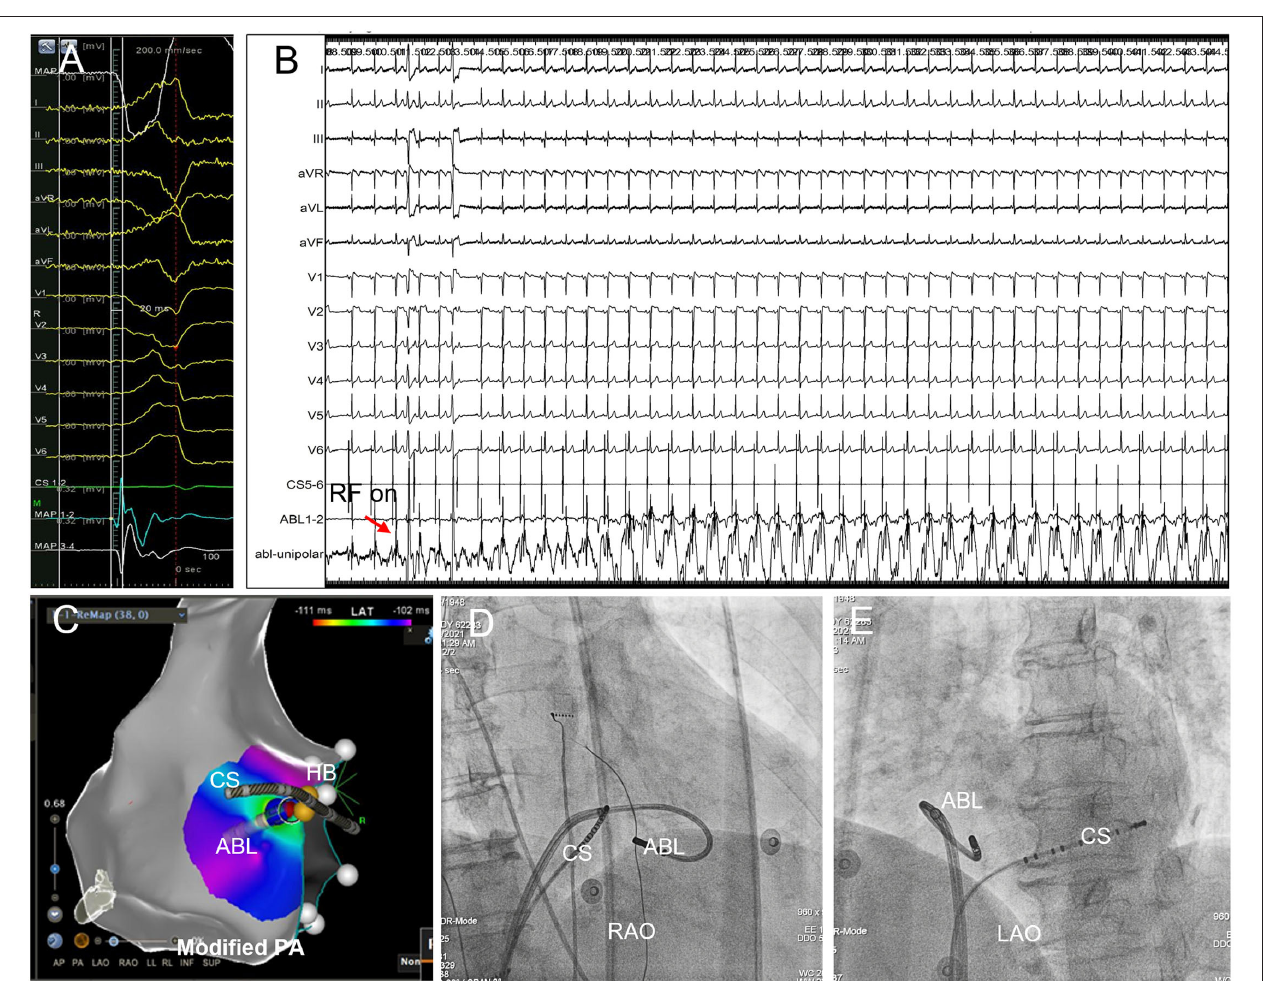
FIGURE 4 | Successful B-SLTV ablation of right PHVA with the ablation target extremely close to the HB. (A) Tracings were unipolar MAP 1 , twelve-lead surface ECG, CS 1 − 2 , bipolar MAP 1 − 2 , MAP 3 − 4 . The local bipolar electrogram at the ablation target preceded the QRS onset by 20ms with a sharp “QS” unipolar electrogram. (B) Saline-irrigated RF energy delivery 35W, 90s at this site successfully abolished the PVC, without junctional rhythm or AV conduction impairment. (C) The catheter tip was positioned beneath the SLTV ≈ 2mm away from the HB. The blue dot represented the ablation lesion. (D,E) The B-SLTV placement of the ablation catheter was displayed on RAO and LAO projection. HB, the His bundle; CS, coronary sinus; ABL, the ablation catheter. PA, postero-anterior; RAO, right anterior oblique; LAO, left anterior